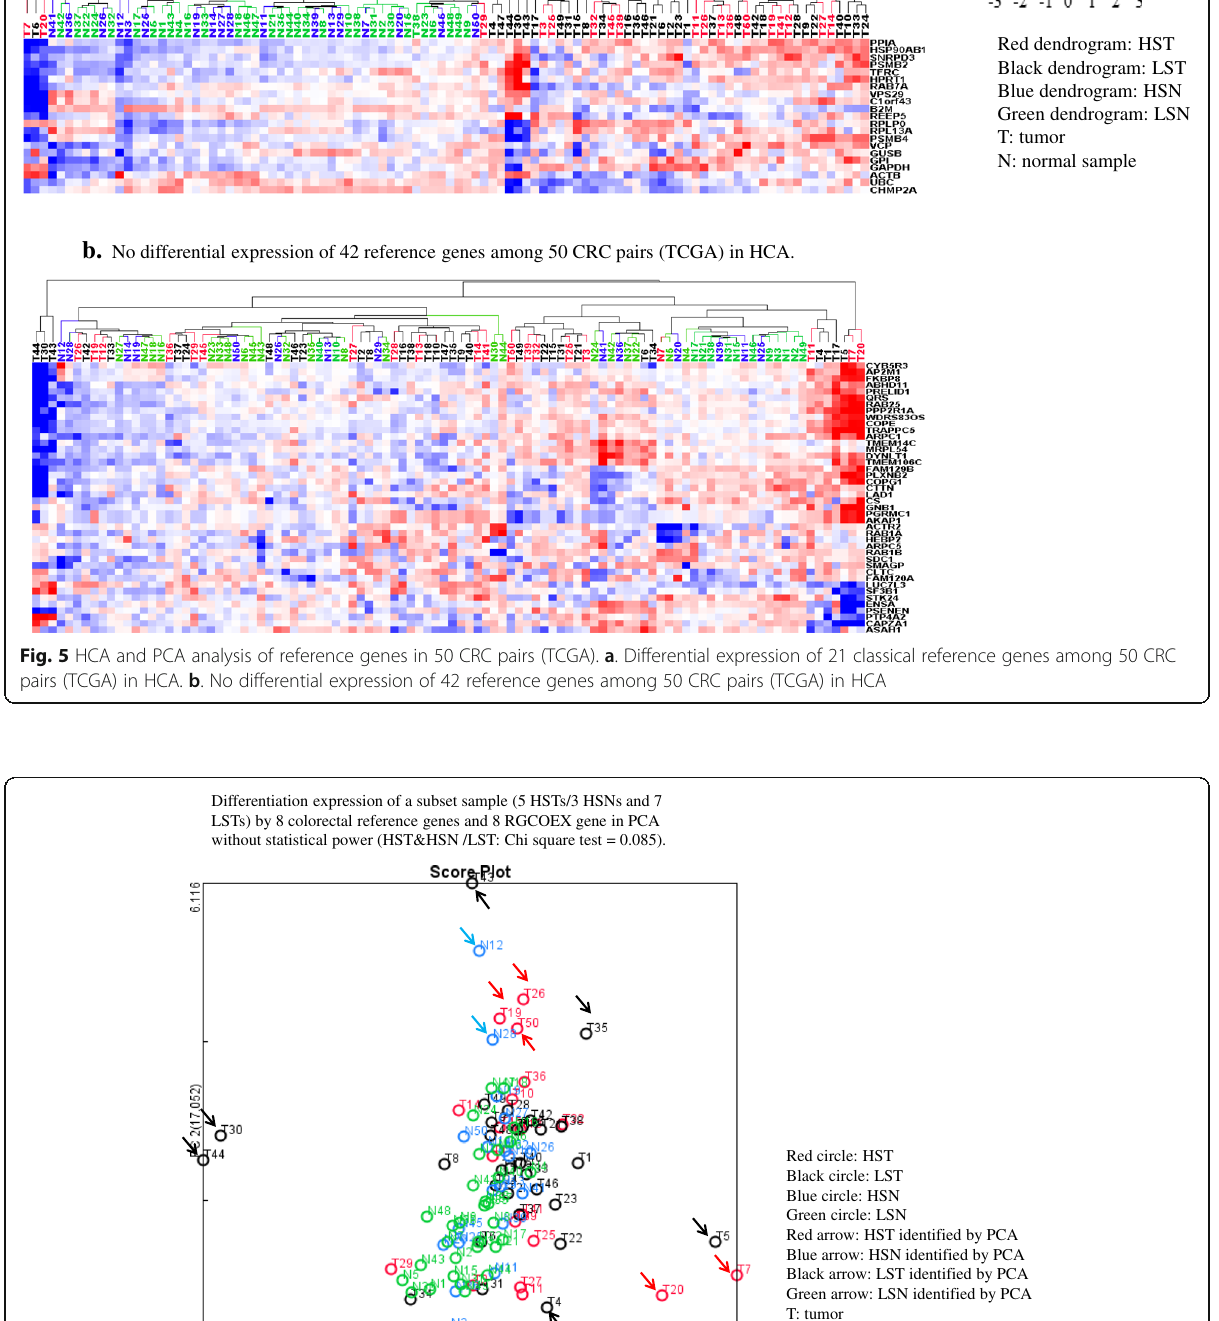
Red dendrogram: HST Black dendrogram: LST Blue dendrogram: HSN Green dendrogram: LSN T: tumor N: normal sample